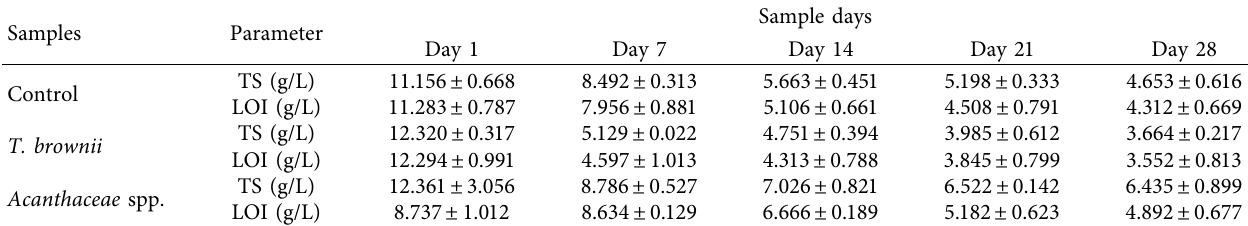
Table 3: Variation of TS and LOI levels in the bioslurry over the retention period.